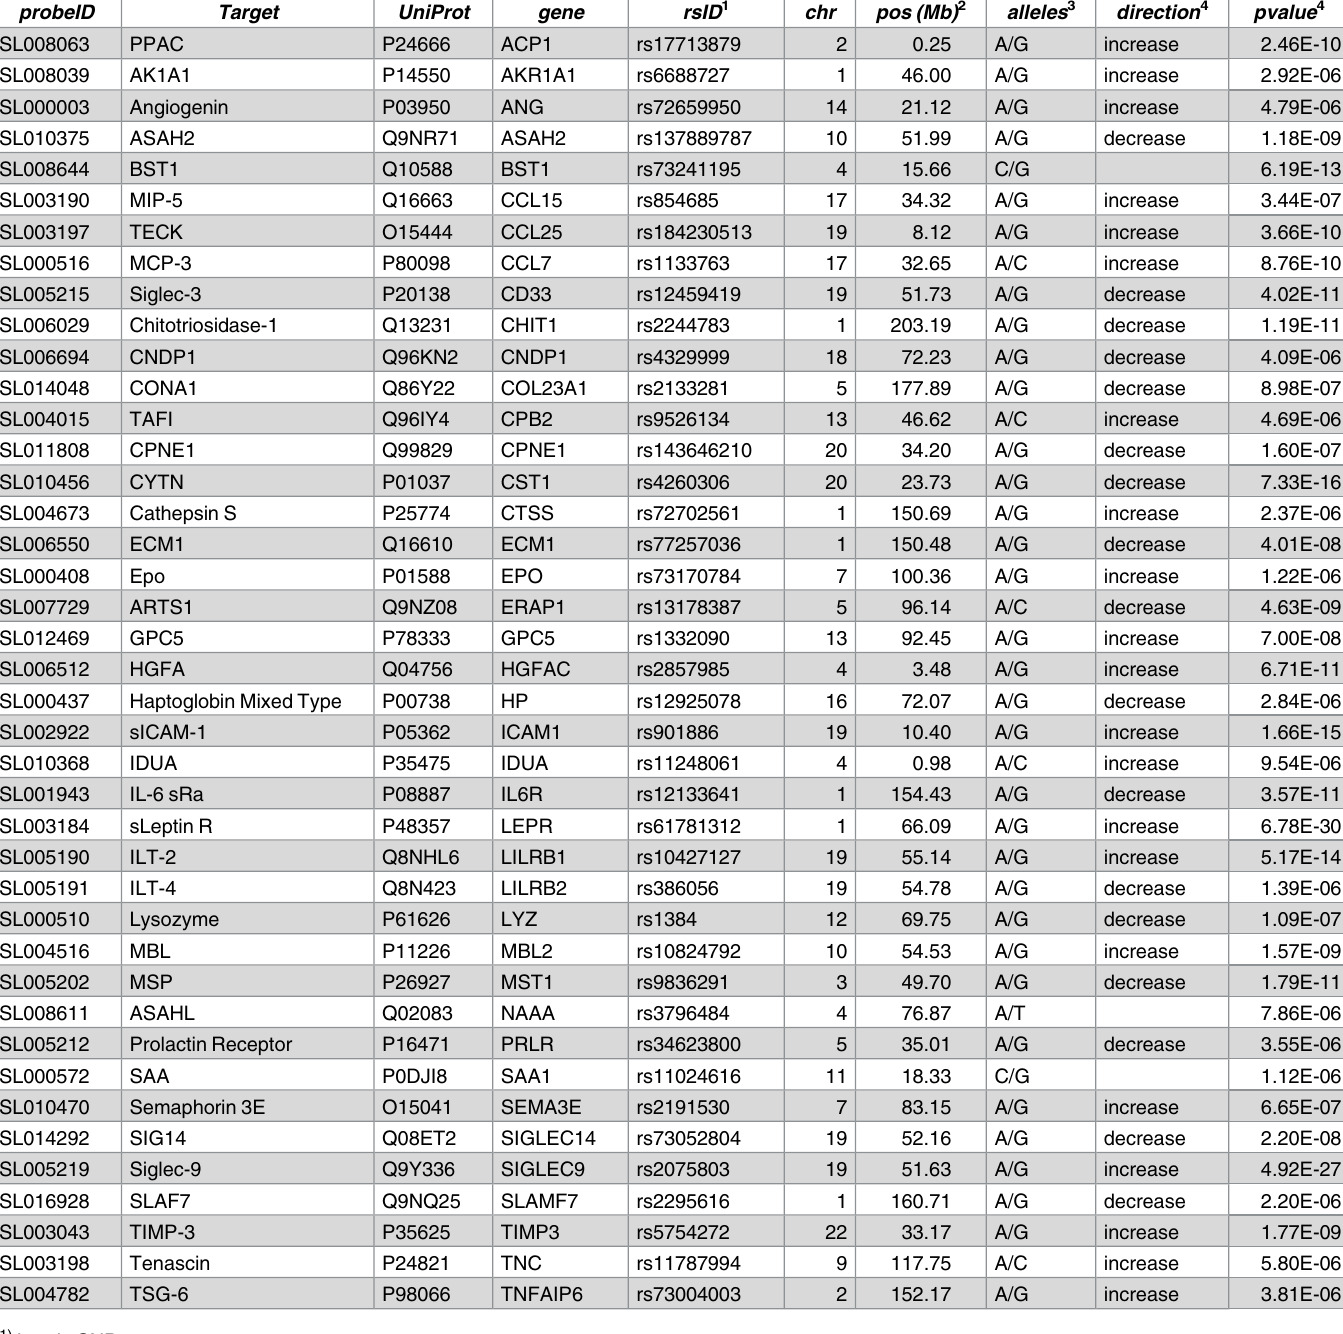
Table 2. Newly discovered protein-QTLs (10% FDR): protein probe and lead significant SNP.